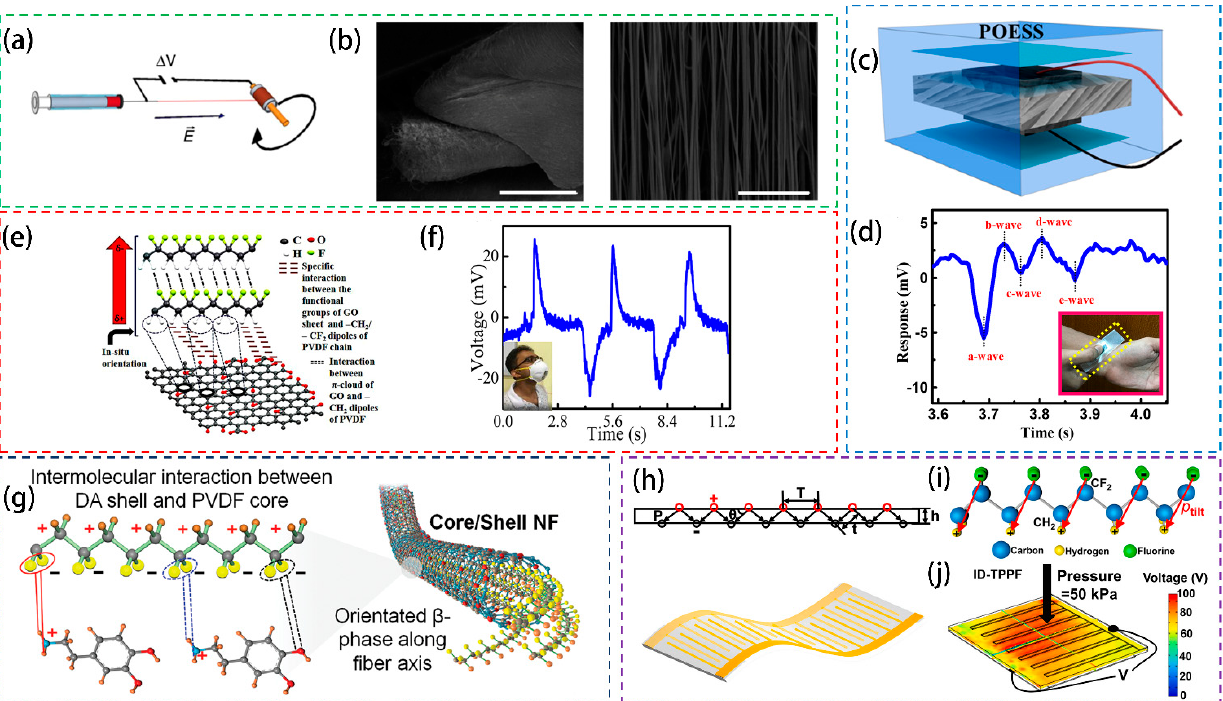
Figure 3. ( a ) Schematic illustration of the experimental setup for electrospinning highly aligned arrays of oriented nanofibers of aligned polymer chains of P(VDF-TrFE). ( b ) Photograph of a free-standing film of highly aligned piezoelectric fibers, SEM micrograph of fibers arrays. Reproduced from [ 21 ] with permission from the Springer Nature, copyright 2013. ( c ) Three dimensional schematic illustrations of piezo-organic e-skin sensor (POESS) design architecture. ( d ) Radial artery pulse measurement response by simply interfacing the POESS to the human wrist. Reproduced from [ 22 ] with permission from the American Chemical Society, copyright 2020. ( e ) Schematic of a hypothetical model for electroactive phase nucleation and interactions present in PVDF/1 wt% GO nanofibers. ( f ) Open circuit voltage of thePVDF/1wt % GO-based nanogenerator devices (photo of the deviceattached to a N95 breathing mask is shown in the inset) driven by human respiration at room temperature. Reproduced from [ 94 ] with permission from the American Chemical Society, copyright 2019. ( g ) A Schematic of the Core/shell PVDF/DA nanofibers. Reproduced from [ 97 ] with permission from the John Wiley and Sons, copyright 2020. ( h ) Schematic illustration of alternatively tilt-polarized P(VDF-TrFE) film. ( i ) Molecular chain arrangement and tilt dipole orientation p tilt of P(VDF-TrFE) polymer. ( j ) The voltage distribution on ID-TPPF under a dynamic pressure of 50 kPa. Reproduced from [ 34 ] with permission from Elsevier, copyright 2021.